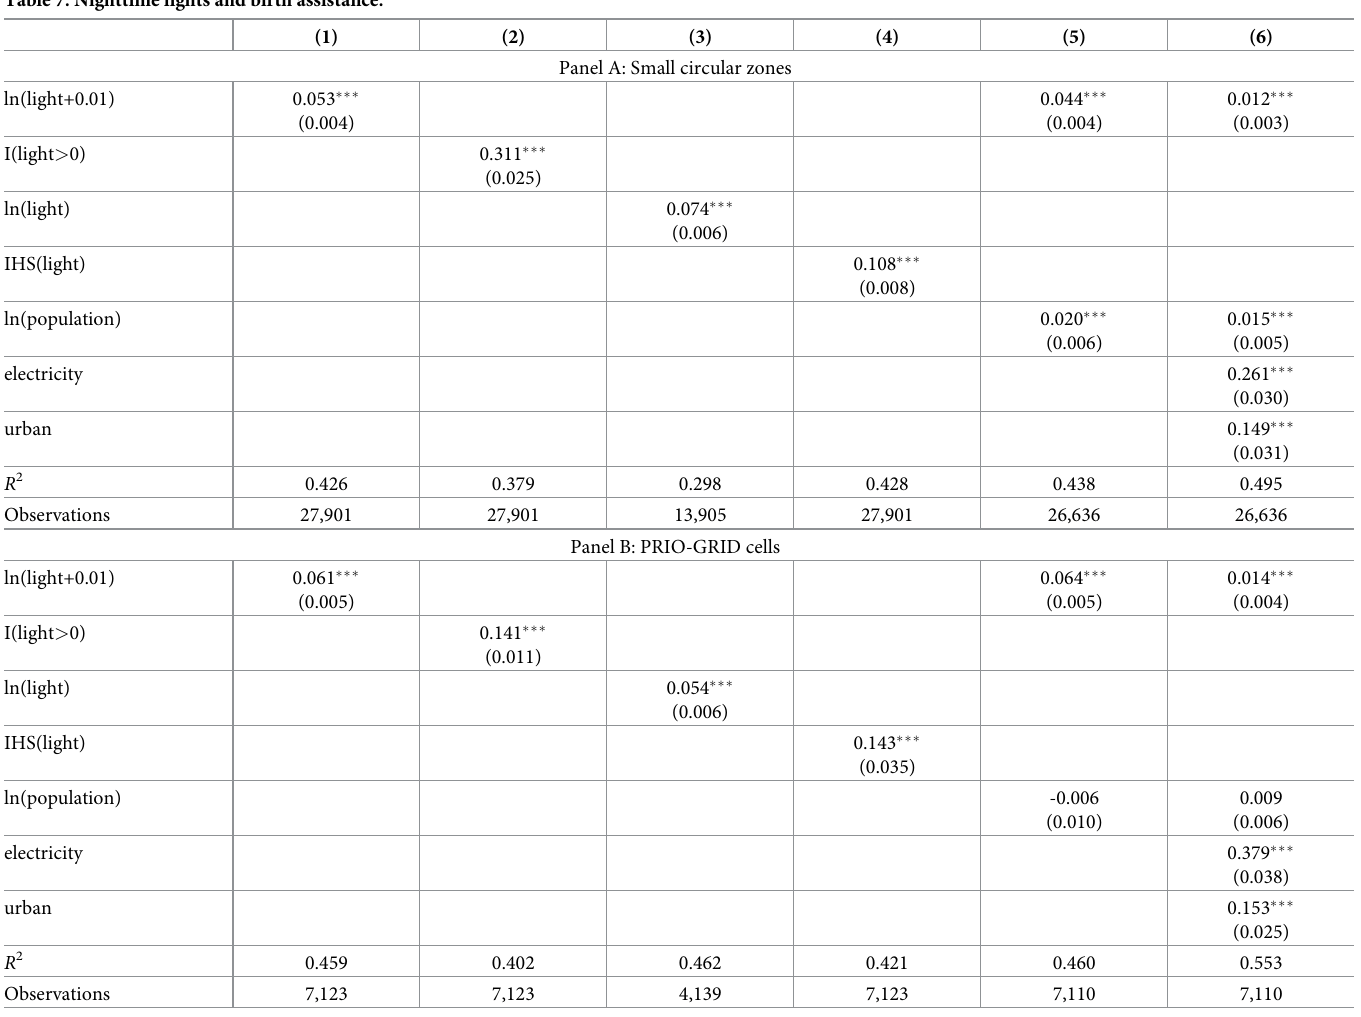
Table 7. Nighttime lights and birth